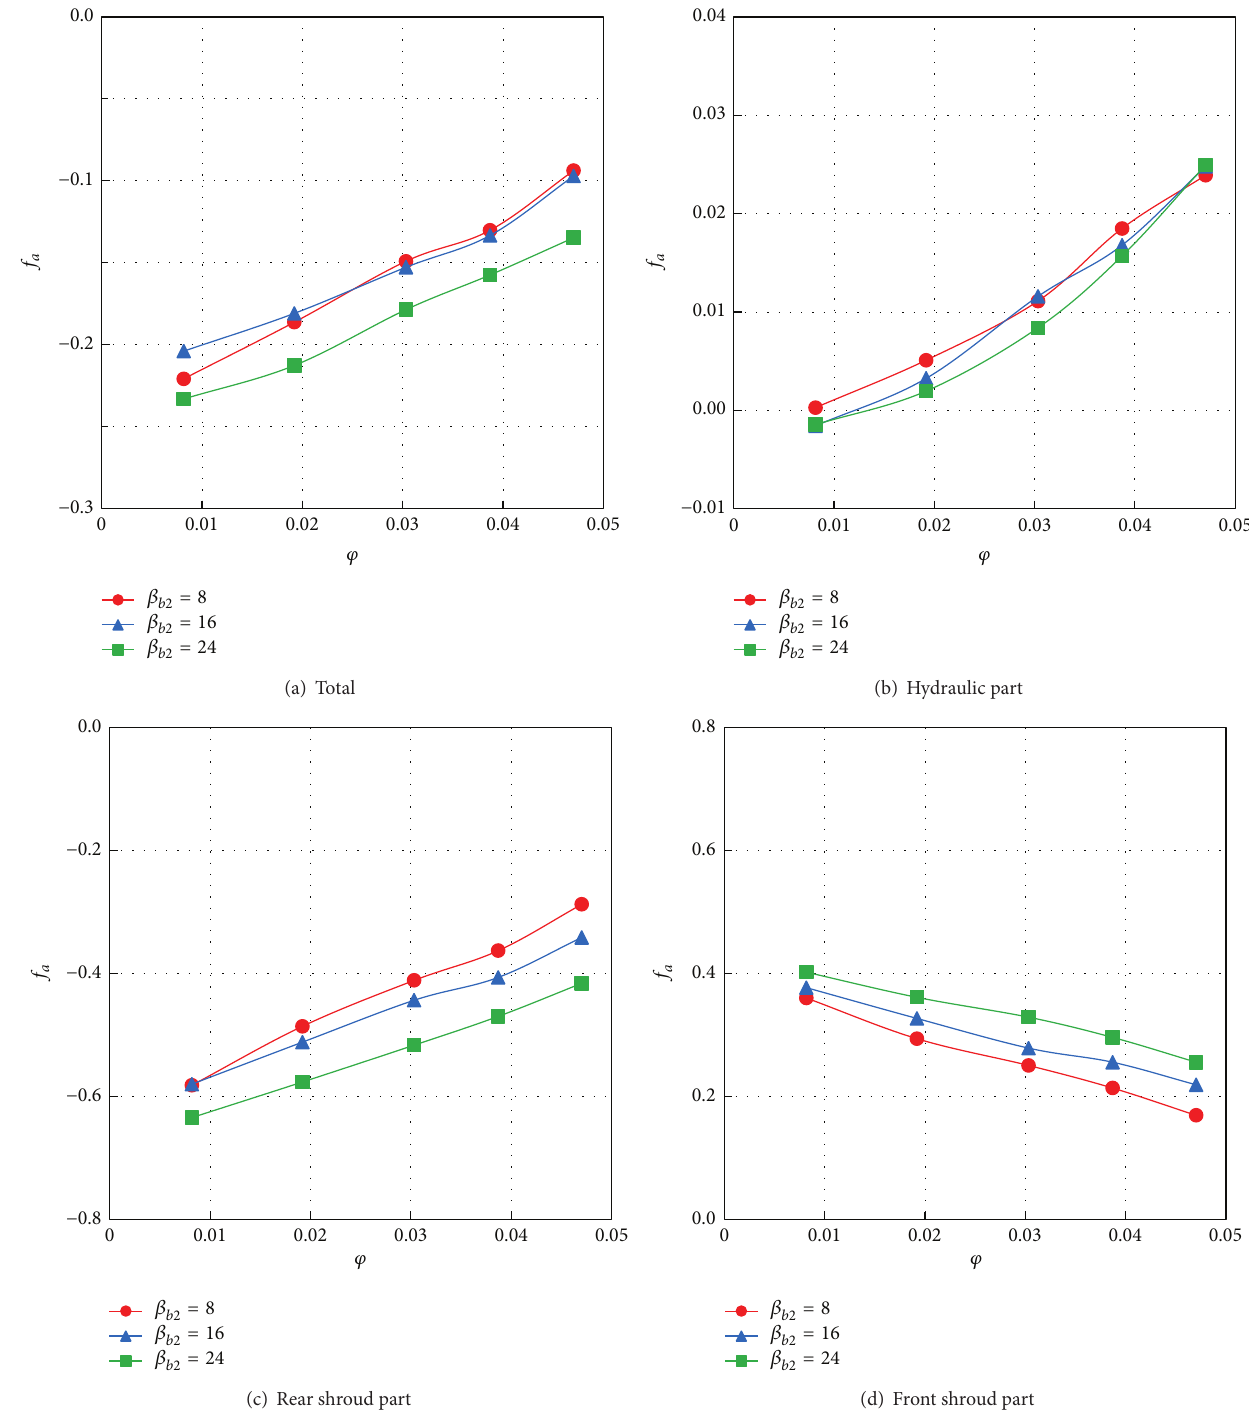
Figure 16: Time-averaged values of axial thrust coefficient ( 𝑓 𝑎 ) on each part as functions of flow rate coefficient ( 𝜑 ).